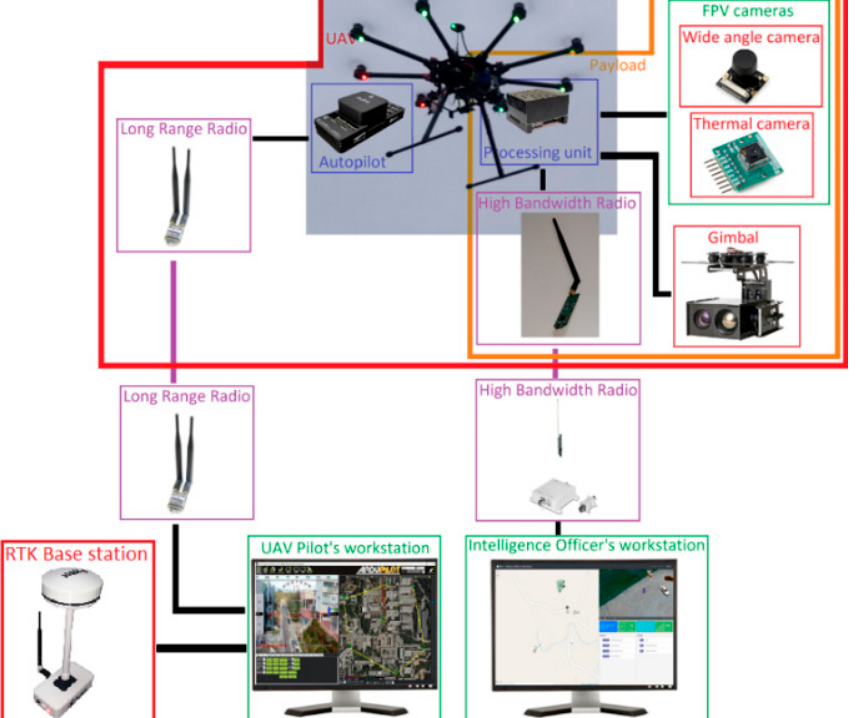
Figure 2. Basic hardware modules of the system.